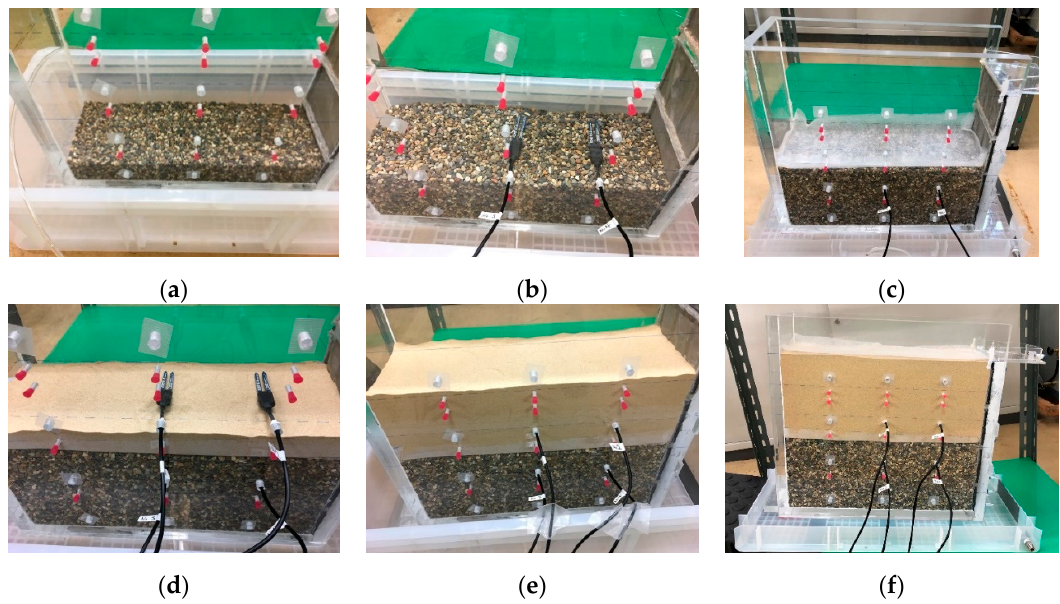
Figure 5. Steps for the preparation of the laboratory SSCB model: ( a ) installation of the first gravel layer; ( b ) installation of sensors No. 3 and No. 4; ( c ) installation of the drainage material; ( d ) installation of the first sand layer and of sensors No. 1 and No. 2; ( e ) installation of the second sand layer; ( f ) after the sand layer was completed, the drainage material was laid on it.